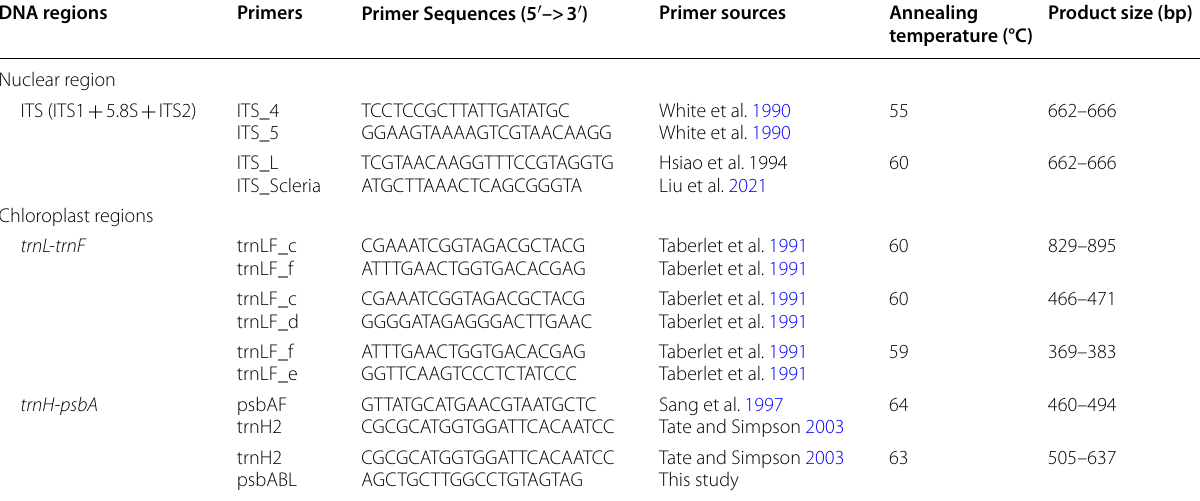
Table 1 The PCR primers, optimal annealing temperatures, and product sizes of ITS, trnL-trnF , and trnH-psbA regions in this study DNA regions